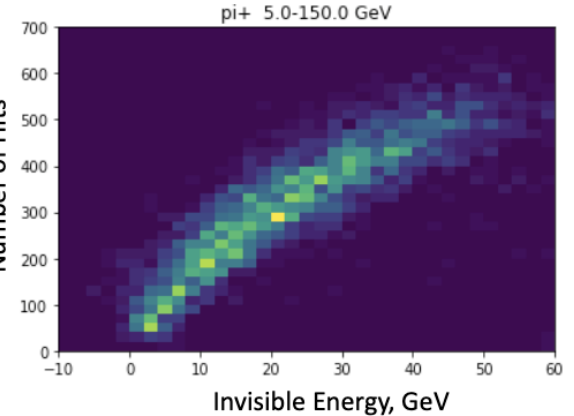
Figure 7. A 2D ( xy ) heat map of a Cherenkov signal in a 40 × 40 cm 2 area: the grid size (1 × 1 cm 2 ) corresponds to the transverse segmentation of the fiber calorimeter and the color scheme indicates the signal amplitude in log ( E ) . ( a ) An example of a large invisible energy event (beam energy 126 GeV and invisible energy 53 GeV) and ( b ) an example of a small invisible energy event (beam energy 127 GeV and invisible energy 1 GeV).